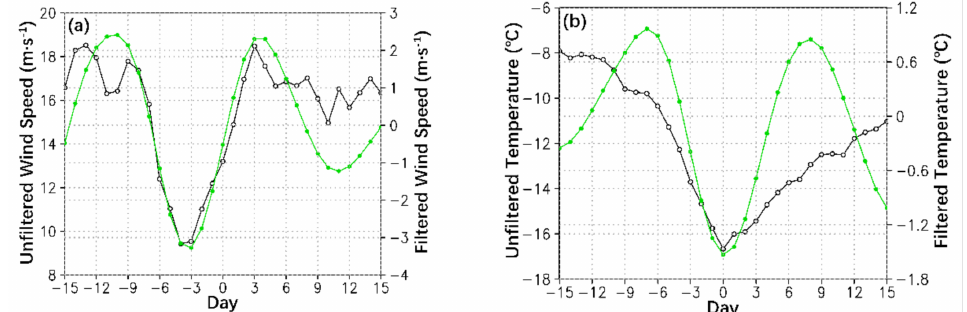
Figure 7. ( a ) Time evolution of the zonal wind (black line) and the 10–20 d filtered zonal wind (green line) in the upper level wind field key area 15 days before and after the WPECE. ( b ) Time evolution of mean air temperature (black line) and the 10–20 d filtered air temperature (green line) in the surface key area 15 days before and after the WPECE.